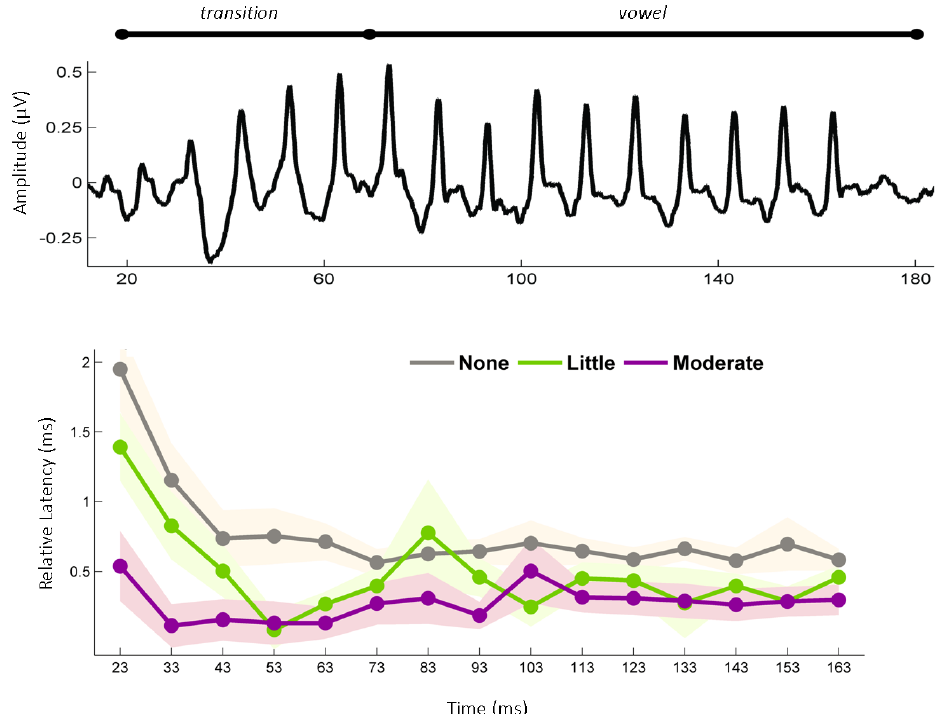
Figure 2. Older adults continue to benefit from music training that occurred early in life. ( Top ) Grand average auditory brainstem response from all participants to the speech sound (da). ( Bottom ) Participants were divided based on their childhood history of musical training into three groups. The “None” group ( gray ) represents those with no musical training, the “Little” group had between 1–3 years of musical training, and the “Moderate” group had between 4–14 years of musical training. The graph represents the relative latency of each prominent peak in the response to “da” presented in background noise, with the shaded regions representing 1 SEM. The larger the value on the ordinate, the greater the shift from the expected latency, and therefore the more delayed the response. Relative to the group with no training, the two groups with past musical experience have earlier latencies, during the first 50 ms corresponding to the “d” to “a” formant transition. Earlier neural timing is suggestive of a physiologically younger auditory system. Modified from White-Schwoch et al.